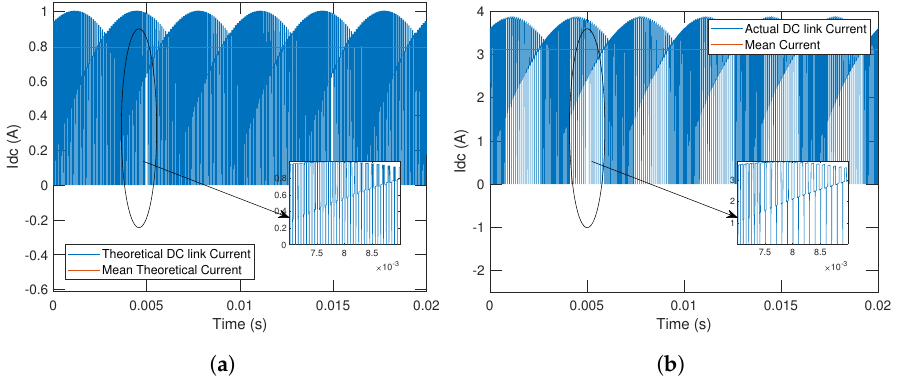
Figure 3. DC − link current for load pf angle = 20 ◦ . ( a ) Theoretically synthesized (using piece-wise formulation). ( b ) Its simulated